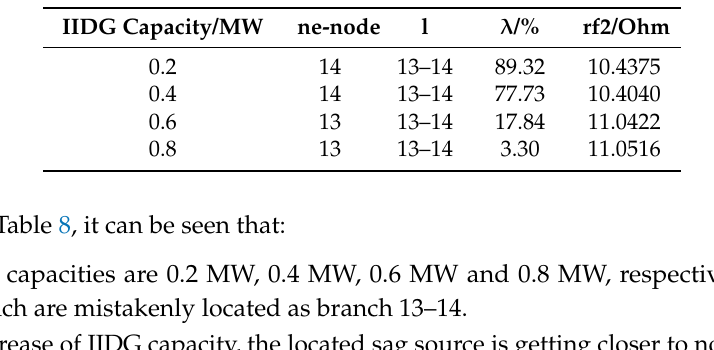
Table 8. Locating results of Strategy 2 with different capacities of